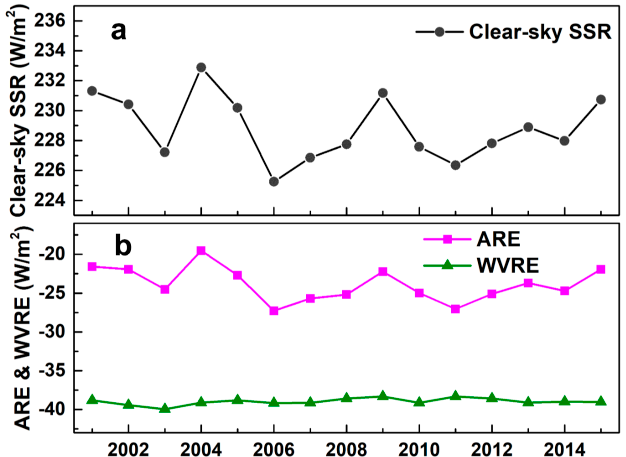
Figure 15. Variations of annual ( a ) clear-sky SSR and ( b ) ARE and WVRE in northern China from 2001 to 2015.